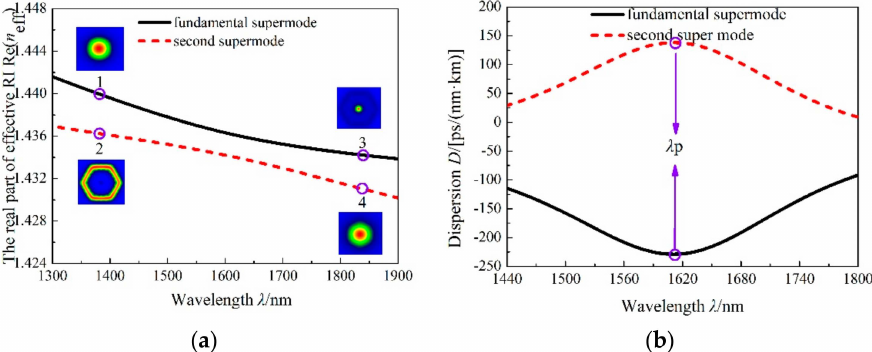
Figure 2. Variation of Re(n e ff ) ( a ) and dispersion ( b ) with wavelength, the illustration is the mode field distribution of the fundamental and second-order supermode at di ff erent wavelengths.